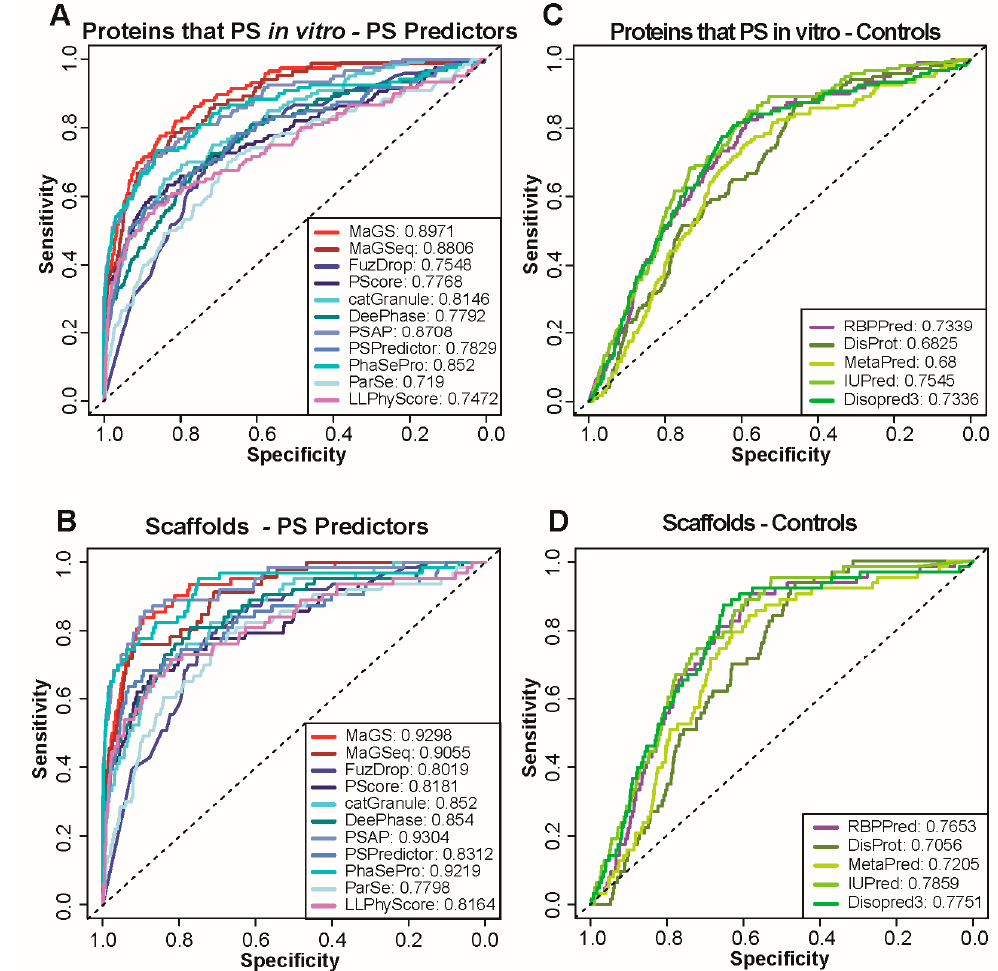
Figure 2. Performance of state-of-the-art methods and simple protein features for in vitro phase separation (PS) prediction. ( A , C ) ROC curves calculated with predictions of the same methods used for Figure 1 ( A ) as well as simple protein features obtained by using the sources listed ( C ). Curves are calculated using proteins known to phase separate in vitro as positives and NS1 as negative set. AUC values are provided for each method in the legend. ( B , D ) ROC curves calculated with predictions of the same methods and features as in A and C. Curves are calculated using only scaffolds as positives and NS1 as negative